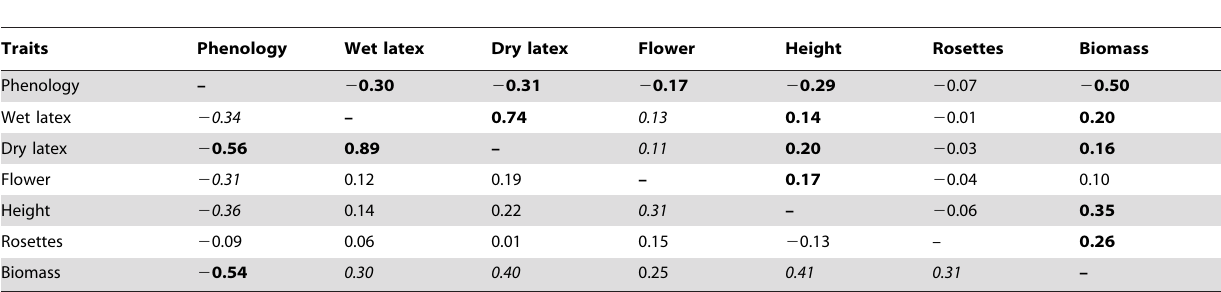
Table 3. Phenotypic and genetic correlations for six traits of greenhouse-grown Lobelia siphilitica .